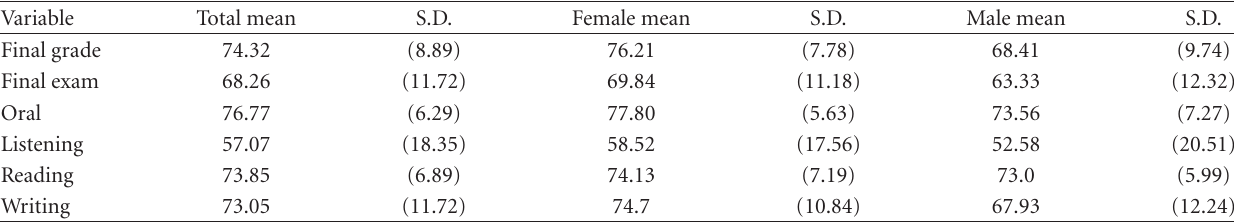
Table 1: Dependent variable means and standard deviations.